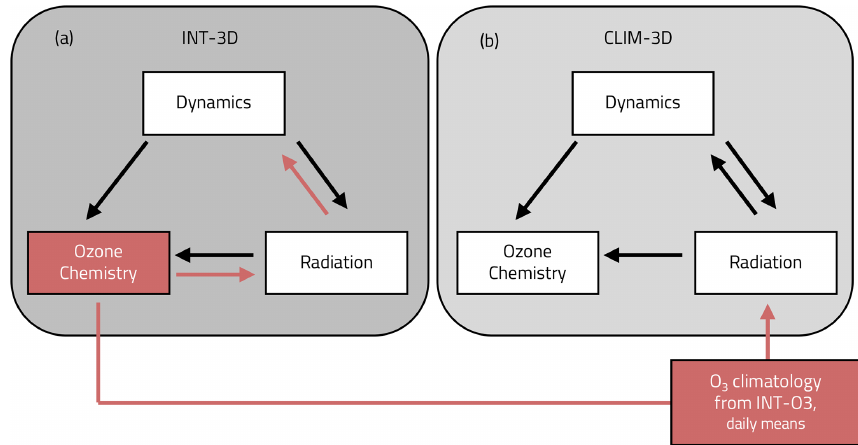
Figure 1. Simulation setup. INT-3D (a) uses a fully interactive chemistry module determining the ozone concentrations as they occur during the run, allowing differences to evolve, in particular from one polar winter to the next, directly feeding back into the model’s radiation schemes and thus the model’s dynamics. In contrast, CLIM-3D (b) is forced by prescribed, daily 3D climatological ozone fields, identical from one year to the next, which have been derived by averaging model runs with fully interactive chemistry (from each respective model, WACCM or SOCOL-MPIOM). The experiments with prescribed ozone (CLIM-3D) still employ the chemistry scheme; i.e., the ozone field is still calculated and affects other radiatively active gases such as methane but does not feed back into the model’s radiative scheme (figure adapted from Friedel et al.,